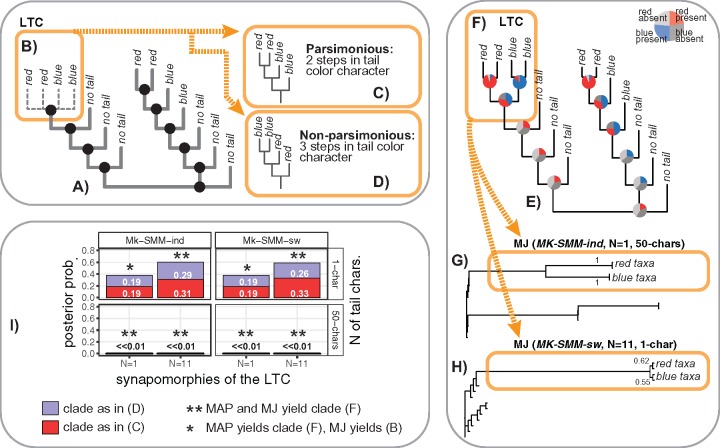
The tail color problem. a) The tree from Maddison (1993) that exemplifies the tail color problem where the tailed species are nested within the two major clades of the tailless species; all relationships are assumed to be resolved (black balls) except those in the left tailed clade (LTC) shown in (b). c, d) Two possible resolutions of the clade (b) when the coding scheme #1 is used: (c) parsimonious resolution; (d) non-parsimonious resolution. e) MAP (maximum a posteriori) tree with the reconstructed ancestral states from the analysis using Mk-SMM-ind, one tail character (1-char), and only one synapomorphy (\documentclass[12pt]{minimal}
\usepackage{amsmath}
\usepackage{wasysym}
\usepackage{amsfonts}
\usepackage{amssymb}
\usepackage{amsbsy}
\usepackage{upgreek}
\usepackage{mathrsfs}
\setlength{\oddsidemargin}{-69pt}
\begin{document}
}{}$N = 1$\end{document}) supporting the LTC. f) One possible resolution of the LTC. g, h) MJ (50% majority rule) trees from Mk-SMM-ind and Mk-SMM-sw analyses with the LTC resolved as shown in (f); numbers indicate posterior probabilities of the subclades in (f). i) Plot of the posterior probabilities of the clades shown in (c) and (d) across all eight analyses. \documentclass[12pt]{minimal}
\usepackage{amsmath}
\usepackage{wasysym}
\usepackage{amsfonts}
\usepackage{amssymb}
\usepackage{amsbsy}
\usepackage{upgreek}
\usepackage{mathrsfs}
\setlength{\oddsidemargin}{-69pt}
\begin{document}
}{}$N =$\end{document} number of synapomorphies (1 or 11) supporting the LTC; x-chars = number of tail characters (1 or 50).